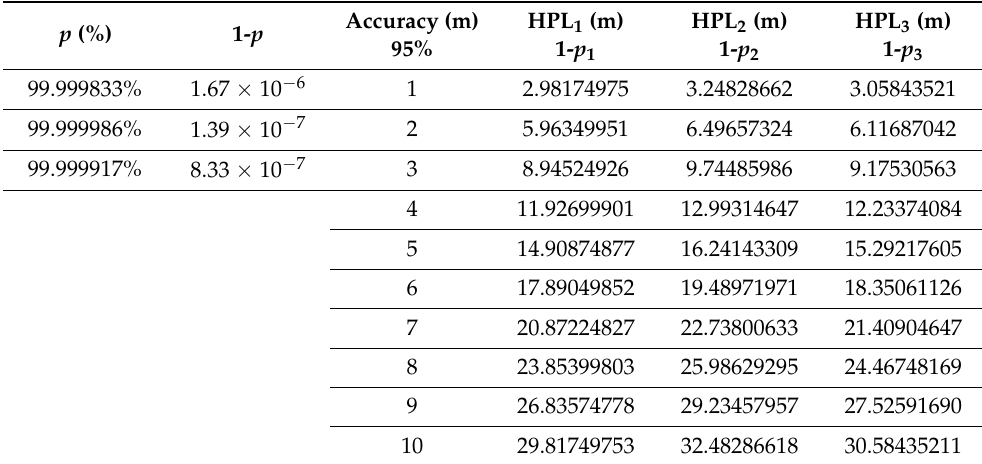
Table 4. Dependence of HPL specified for p on 95% accuracy.